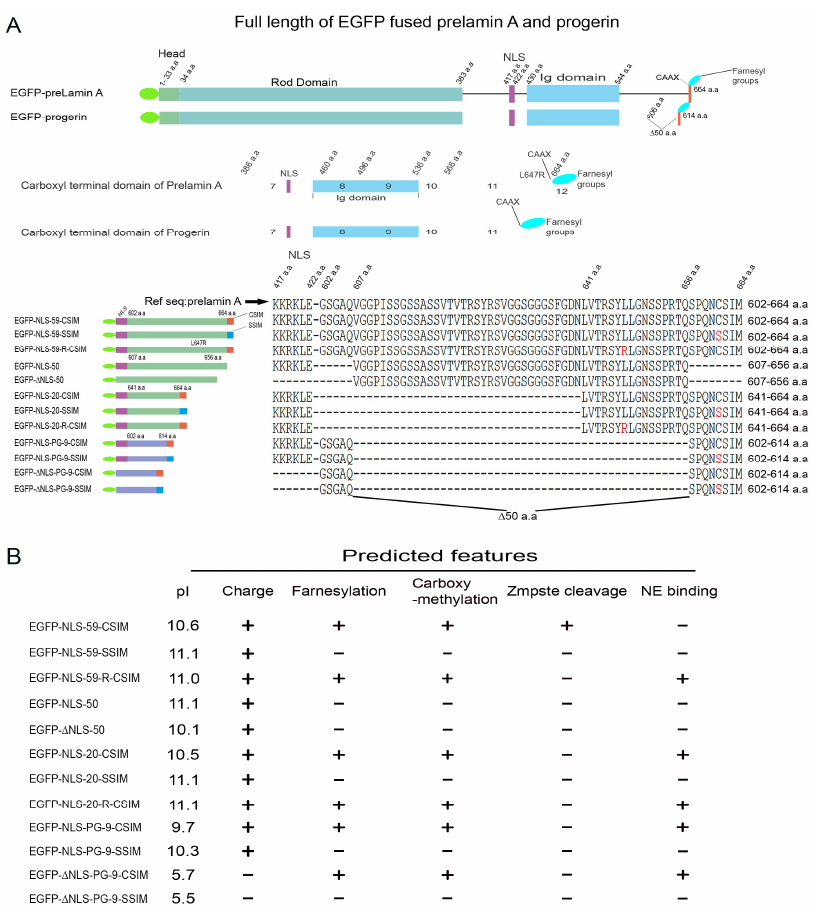
Figure 1. Schematic representation of the C-terminal fragments of prelamin A and progerin. ( A ) Schematics depicting the structures of the EGFP–prelamin A and EGFP–progerin proteins, and constructs derived from their C-terminal domains. The C-terminal domain of the indicated protein is enlarged and the alignment of the construct sequences is shown. (1) Residues from 602 to 664 a.a. (amino acids) are marked as 59-CSIM/SSIM/R-CSIM, which represents the wild type, C661S mutant, and L647R mutant C-terminal fragments of prelamin A, respectively. (2) The 50 a.a. construct encodes the 50 a.a. in-frame deletion of prelamin A from 607 to 656 a.a. (3) Residues from 641 to 664 a.a. of prelamin A are marked as 20-CSIM/SSIM/R-CSIM, which represent the short form of wild type, C661S mutant, and L647R mutant C-terminal fragments of prelamin A, respectively. (4) The PG-9-CSIM/SSIM, residues from 602–614 a.a. of progerin, represents the C-terminal fragment of progerin and its corresponding C661S mutant form. A nuclear localization signal (NLS, KKRKLE) was linked to a part of the constructs as indicated. ( B ) Based on the protein sequence properties, predicted features of all constructs were indicated: pI value, static charge, and post-translational properties, including farnesylation, carboxymethylation, Zmpste cleavage, and nuclear membrane binding ability.